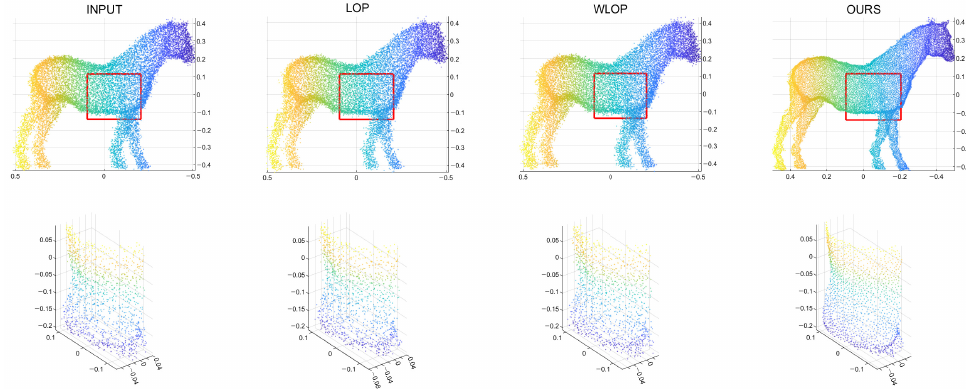
Figure 6. Qualitative results for a tangential noise case (Horse). The second row shows the enlarged views of the red boxes in the first row. The first column shows the input point cloud. The second column shows the result of the LOP. The third column shows that of the WLOP. The last column shows that of the proposed